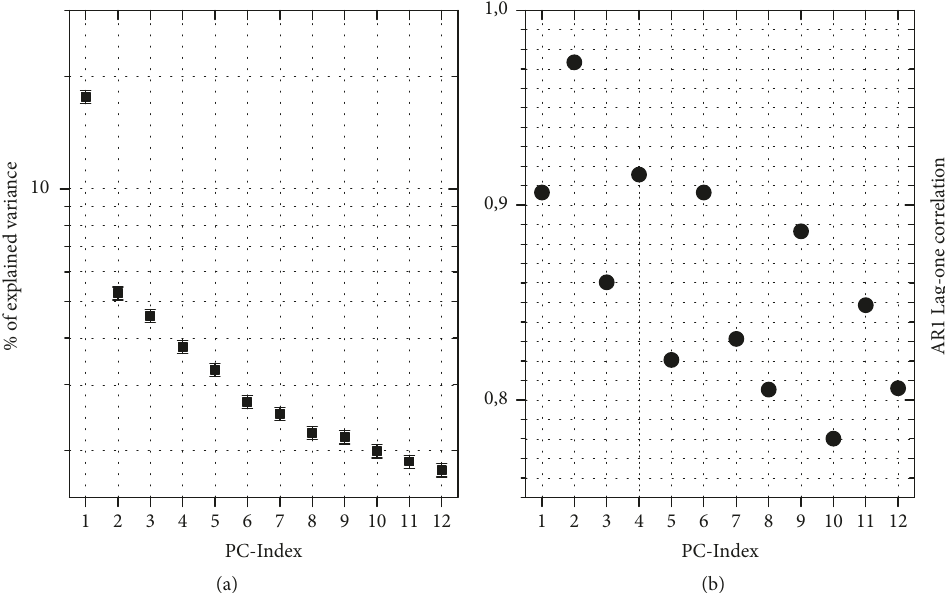
Figure 2: (a) % of explained variance confidence interval and (b) lag-one autocorrelation of the AR (1) fitting model of the leading 12